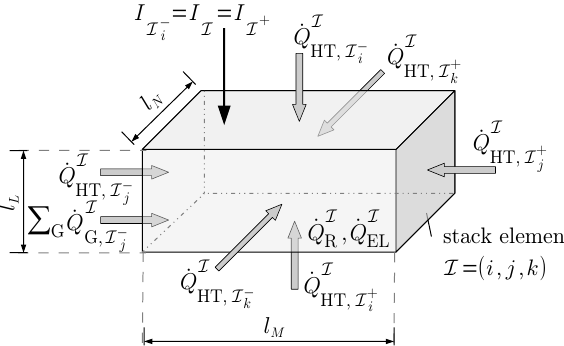
Figure 3. Local energy balance of the semi-discretized fuel cell stack module.